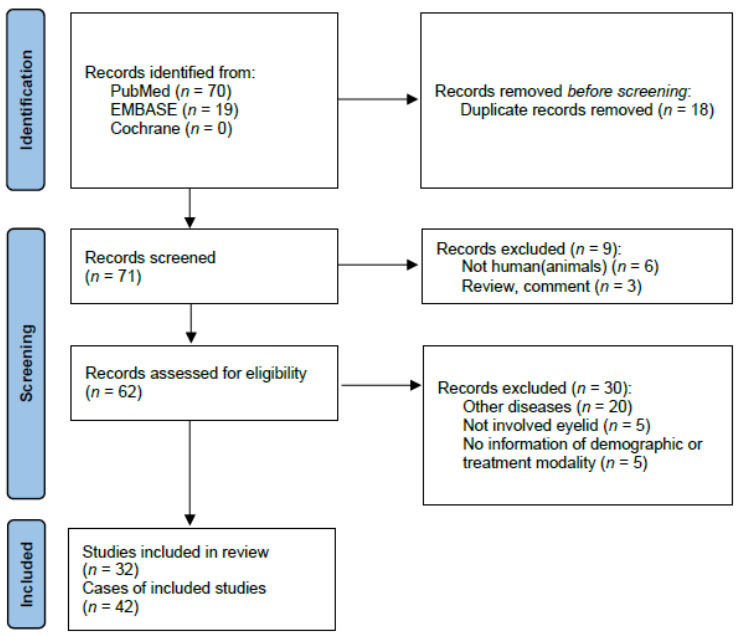
Figure 1. Flow diagram of study collection through exclusion criteria in this